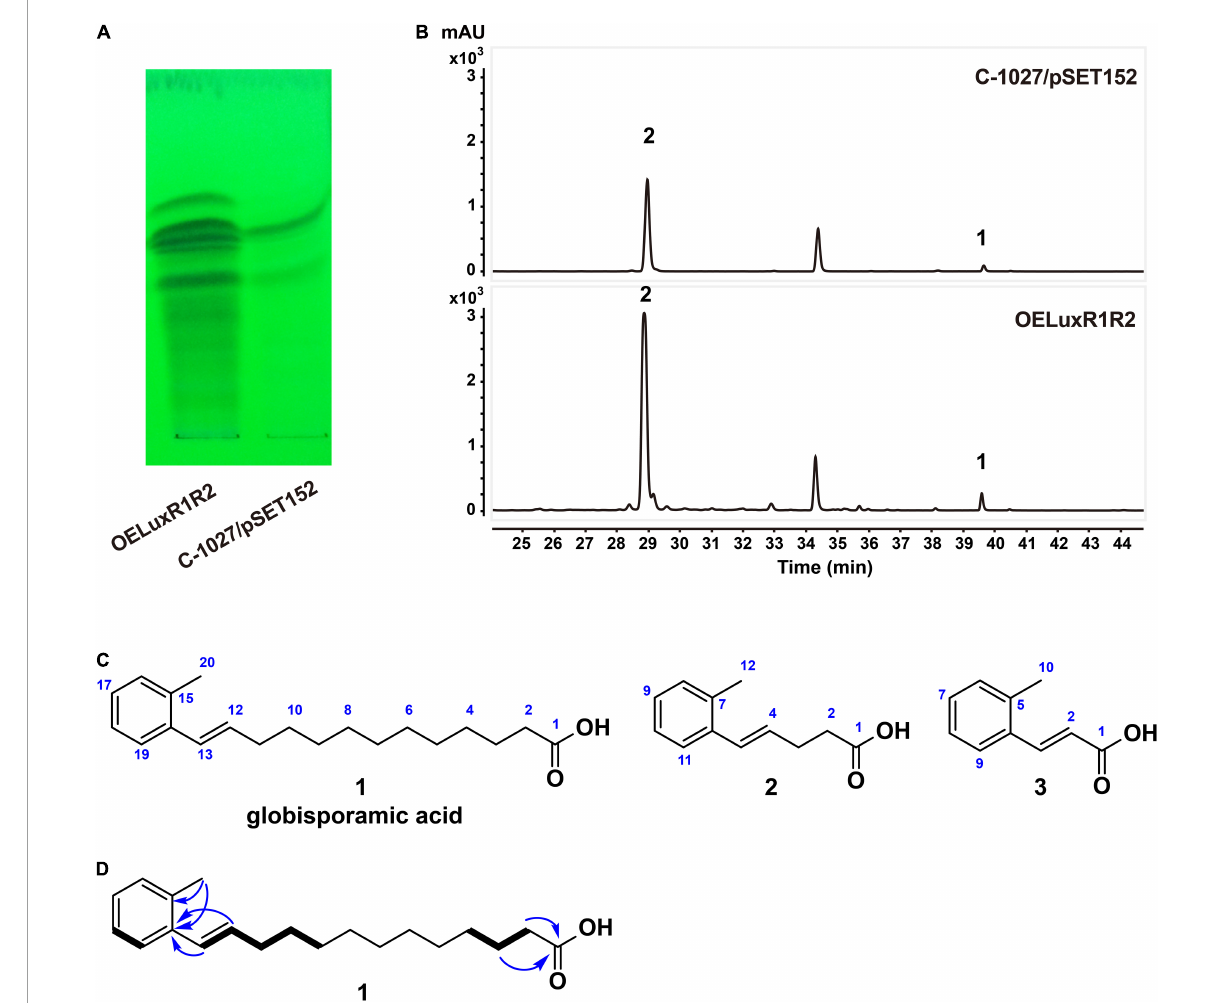
FIGURE2 Metabolic profiles and compounds produced by recombinants. Analysis of the metabolic profiles between regulator-overexpression strain OELuxR1R2 and control strain C-1027/pSET152 by TLC (A) and HPLC (B) analysis. (C) Chemical structures of three compounds isolated from OELuxR1R2. (D) The 1 H- 1 H COSY (thick bonds) and key HMBC correlations (arrows) of compound 1 .